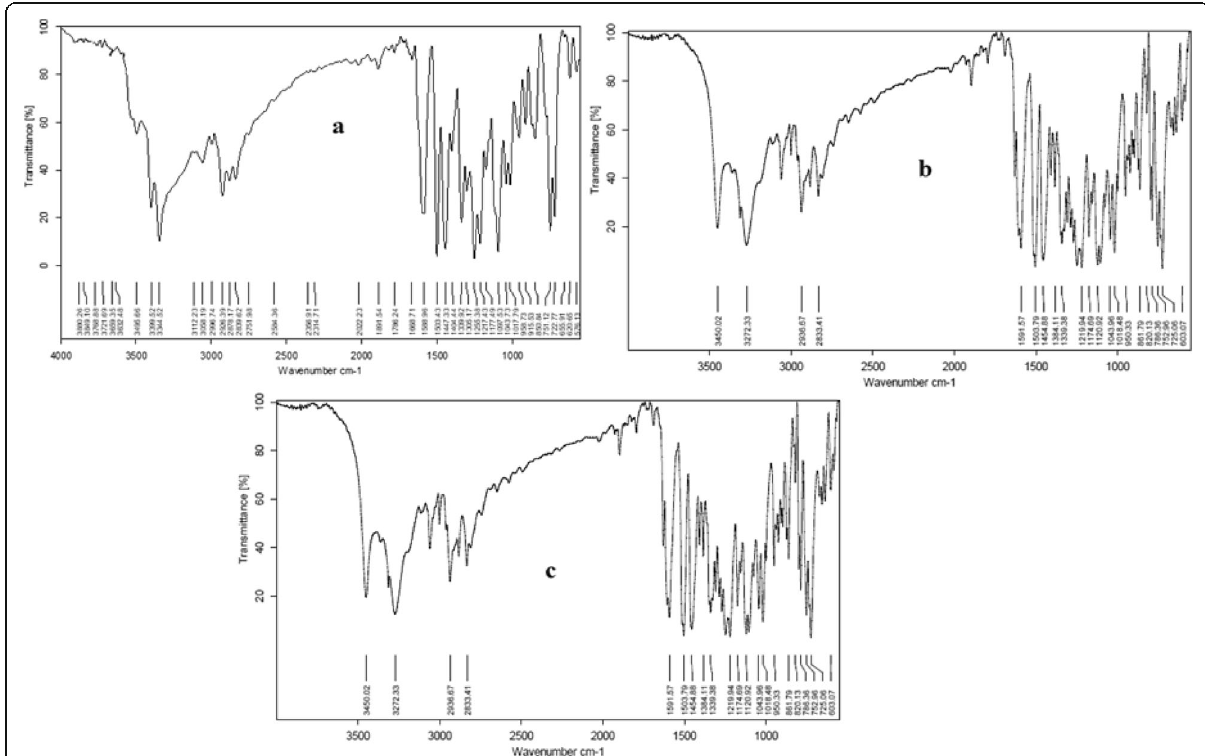
Fig. 6 a FTIR spectra of pure CAR. b FTIR spectra of pure HCT. c FTIR spectra of